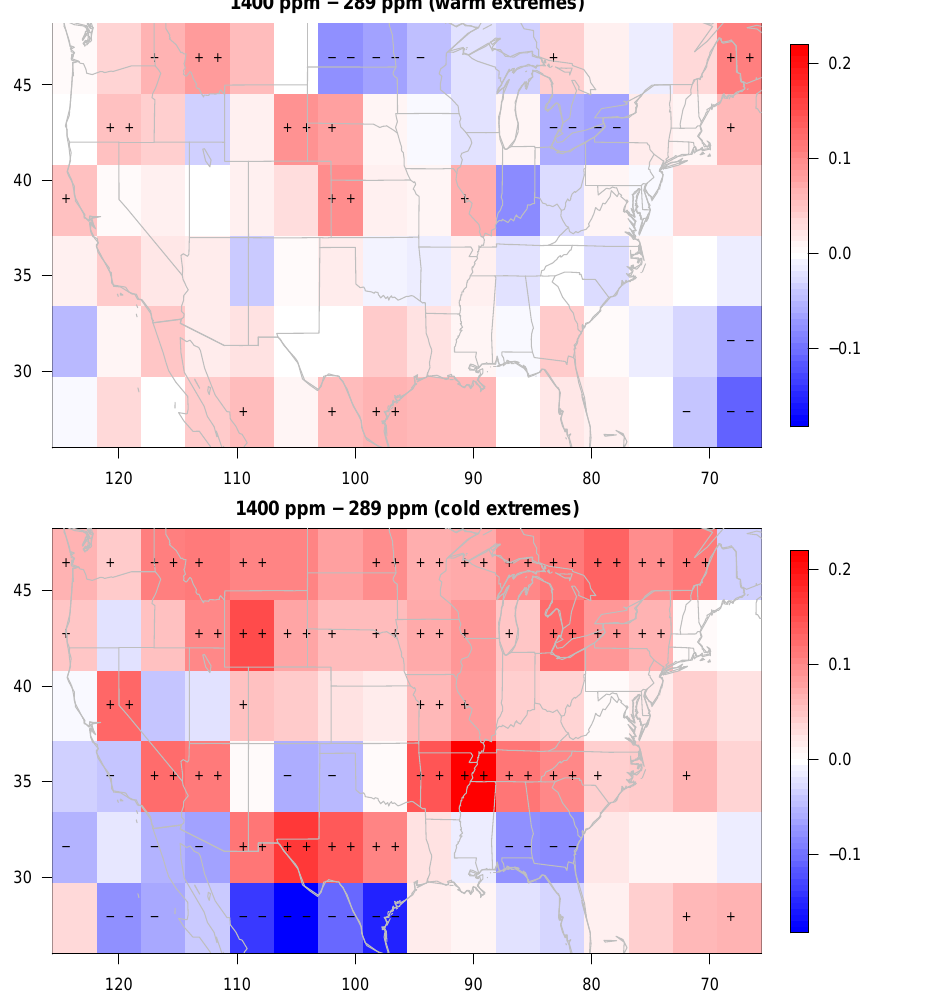
Figure F1. Changes in the estimated CCSM3 GEV shape parameter in the transition from pre-industrial to 1400ppm climate states. Top: warm extremes. Bottom: cold extremes. Changes in the shape parameter are in general significant for inland cold